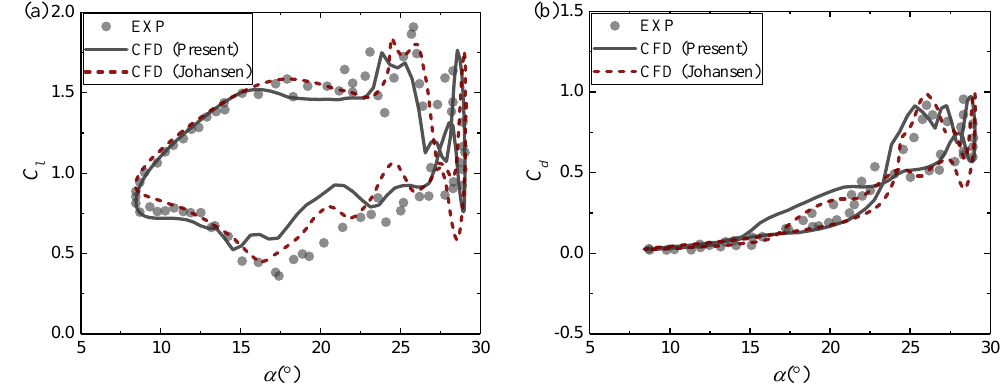
Figure 4. Calculated and measured pressure distributions of the DU97-W-300 airfoil with and without VGs. ( a ) Without VGs; ( b ) with VGs ( x VG / c = 20%).